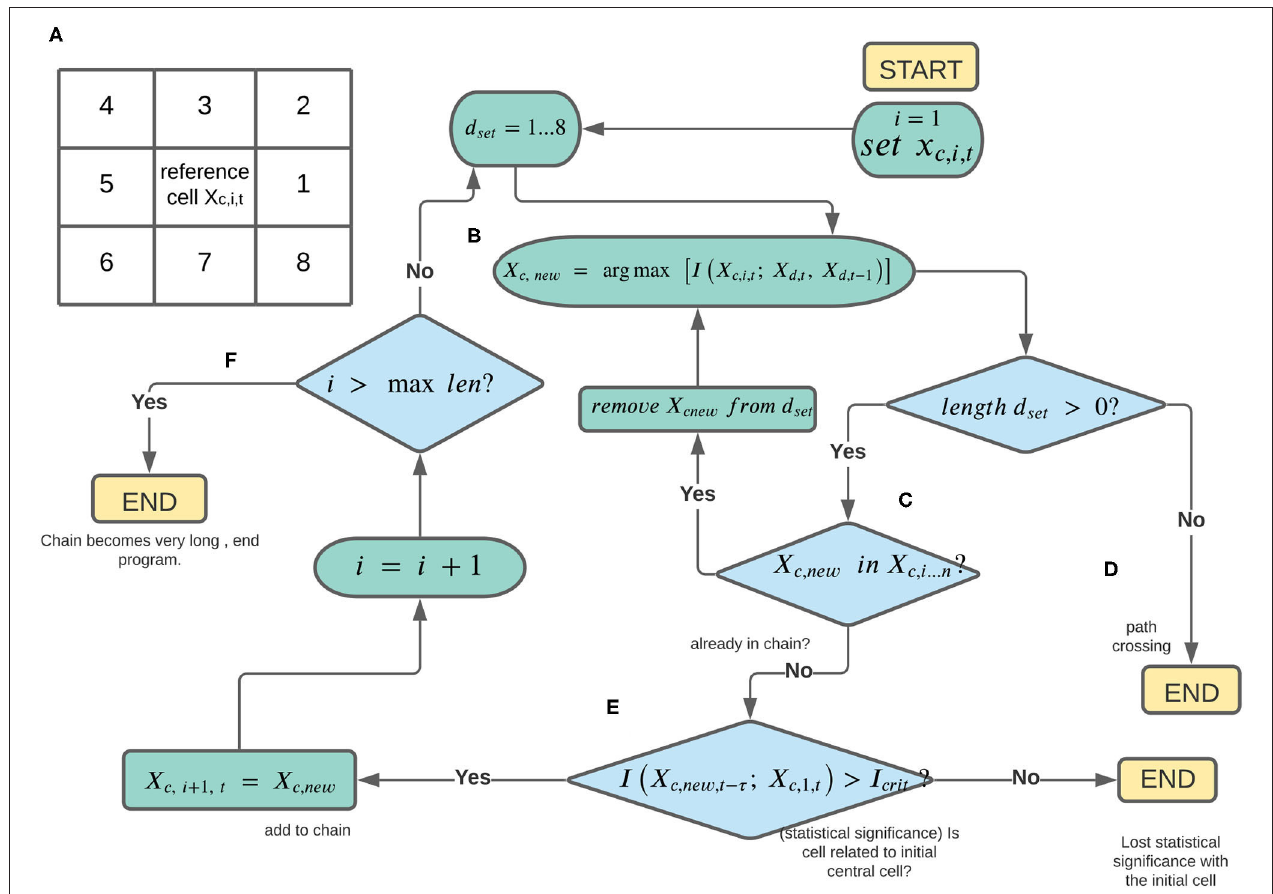
FIGURE 1 | Diagram illustrating development of a precipitation chain of influence for a chosen reference grid cell. These steps (A–F) are further enumerated in the main text, section